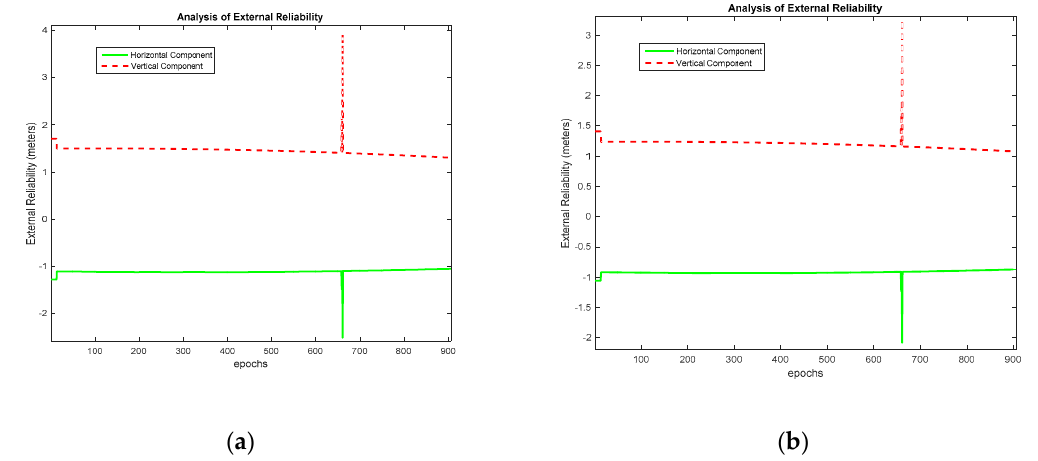
Figure 11. External reliability assessment for Dataset 2. ( a ) α 0 = 0.1%, ( b ) α 0 = 1%.